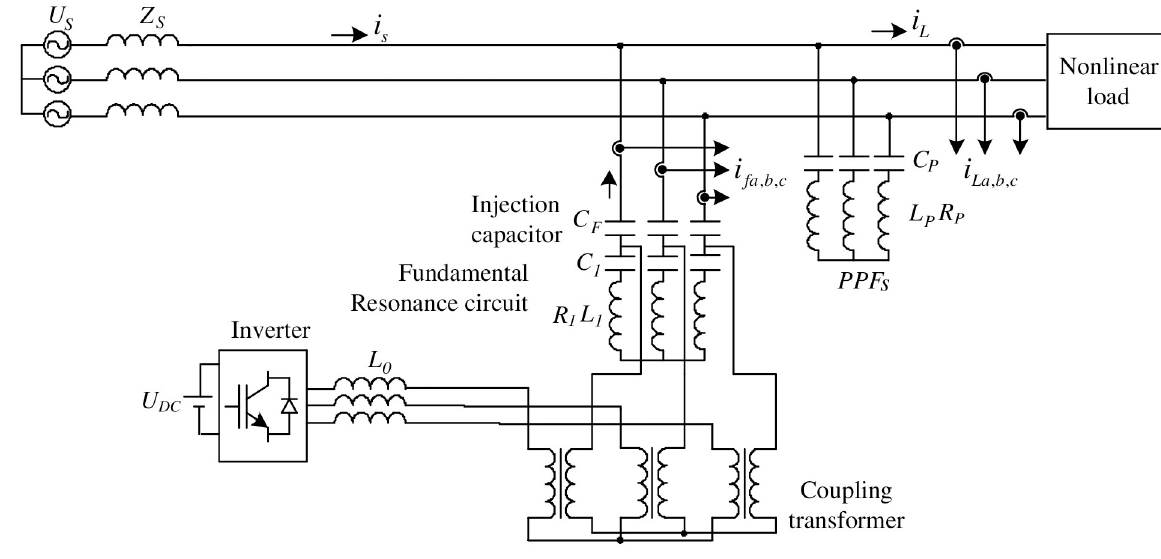
Fig 1. Structure of an IHAPF.